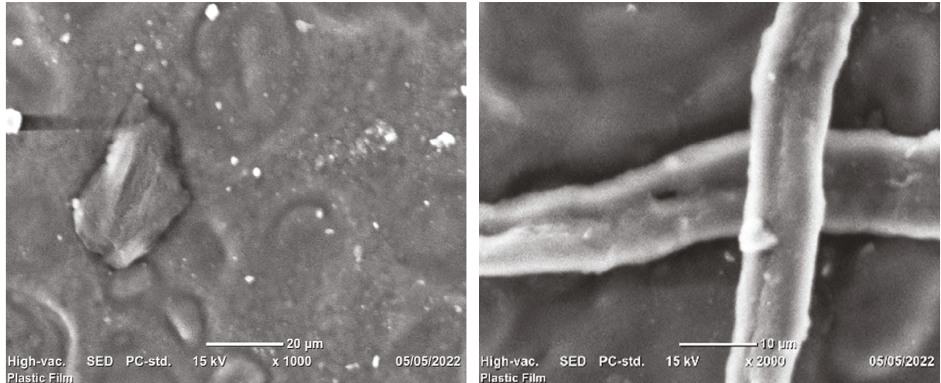
Figure 6: Morphological structure of blend film ( × 1000, × 2000 magnifications).